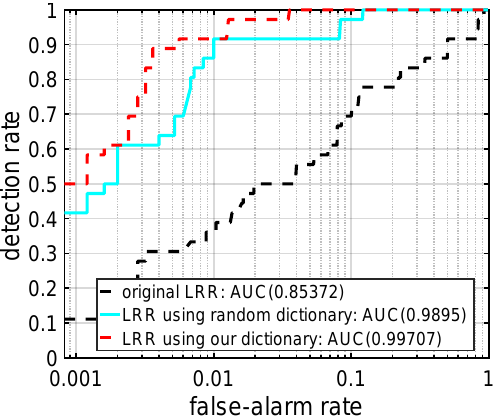
Figure 9. Color detection maps obtained by LRR using different dictionaries for the toy dataset. ( a ) Ground- truth map; ( b ) Original LRR; ( c ) LRR using randomly selected dictionary; (d) LRR using our dictionary.